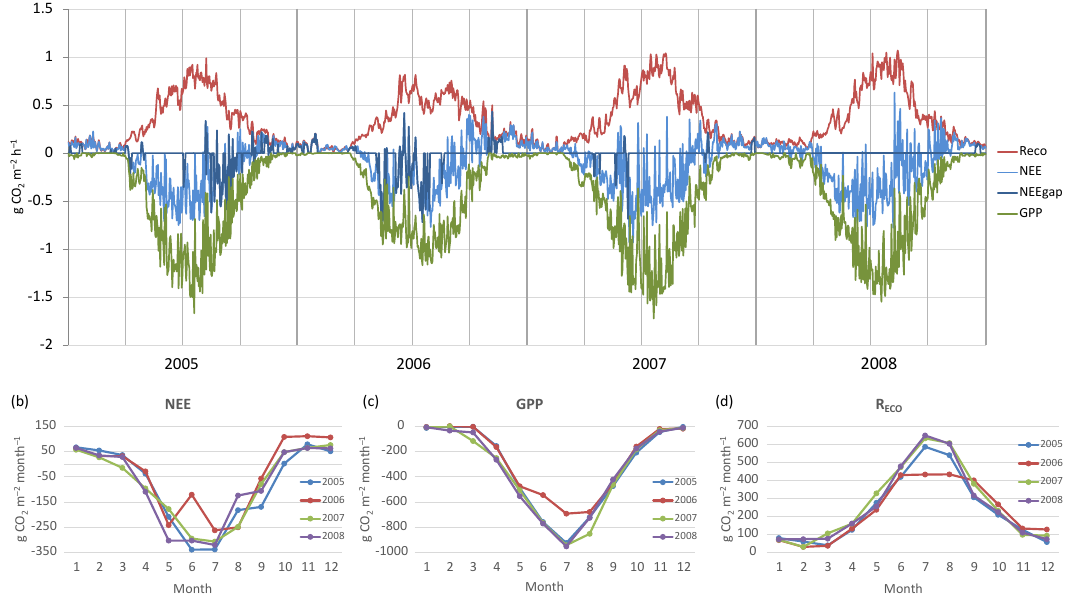
Figure 4. (a) Gap-filled and partitioned daily NEE, GPP and R ECO at Kalevansuo 2005–2008. Full days with missing data shown with dark blue (NEE_gap). (b) Monthly NEE; (c) monthly GPP; and (d) monthly R ECO